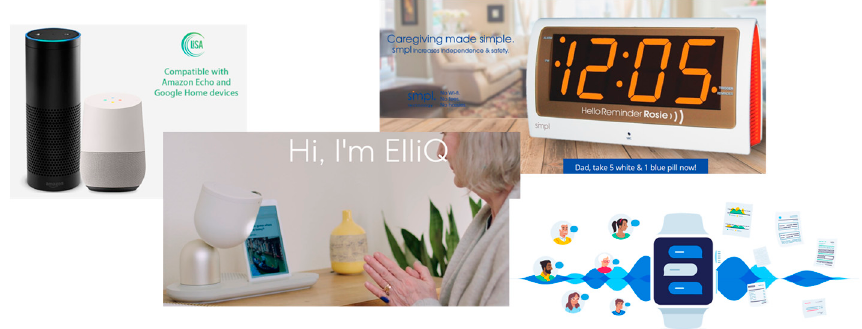
Figure 2. Healthcare home products and hands-free voice devices. Healthcare platforms, such as Cuida Health LISA [18] (left), work with Amazon Alexa and Google Assistant smart speakers. Many are actually hands-free voice devices, such as Rosie Reminder [24] (right) and ElliQ [22] (center), others are wearable, as Notable [17] (bottom-right).